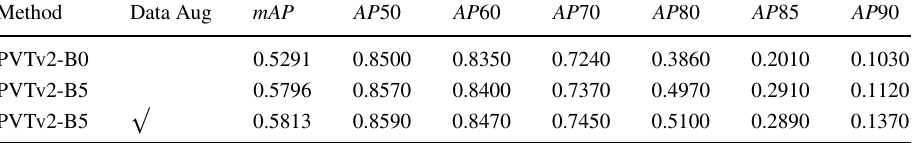
Table 6 Ablation